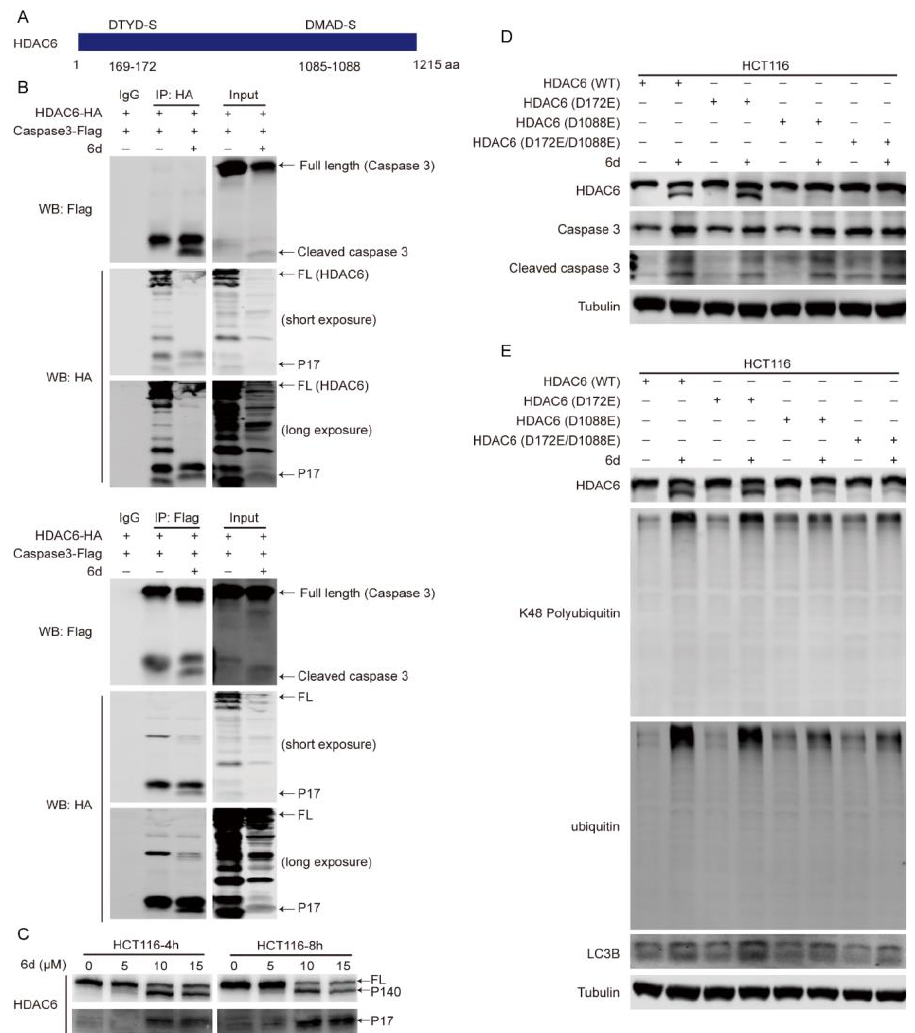
Figure 6. HDAC6 is truncated by caspase 3 at D1088 site. ( A ) Diagram showing the putative caspase 3 cleavage motifs in HDAC6. ( B ) HDAC6 is cleaved by caspase 3 at C-terminal. HCT116 cells were transfected with HDAC6-HA (HA-tagged at the C-terminal of HDAC6) and caspase 3-Flag (Flag- tagged at the C-terminal of caspase 3), and treated with or without compound 6d , followed by HA or Flag for IP and corresponding primary antibodies for WB. ( C ) Endogenous HDAC6 was truncated into ~140 kDa and ~17 kDa fragments. HCT116 cells were exposed to the indicated concentrations of compound 6d for 4 h and 8 h, respectively, and then the lysates were subjected to WB. ( D ) HDAC6 was cleaved at D1088 within the C-terminal in the presence of compound 6d . HCT116 cells transfected with wild-type (WT) or mutated HDAC6 plasmids were treated with compound 6d , and then HDAC6, caspase 3, cleaved caspase 3 and tubulin were detected by WB in total cell lysates. ( E ) The mutation at D1088 site of HDAC6 weakens the effect of compound 6d on the accumulation of K48-linked ubiquitinated proteins and LC3B. The transfected HCT116 cells were exposed to compound 6d , and followed by WB using anti-ubiquitin, specific anti-K48-linked ubiquitin, and anti-LC3B antibodies.